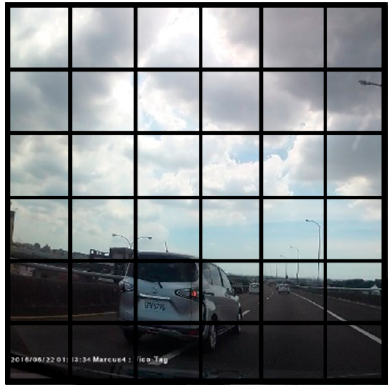
Figure 2. The input image is divided into 6 × 6 grid cells.